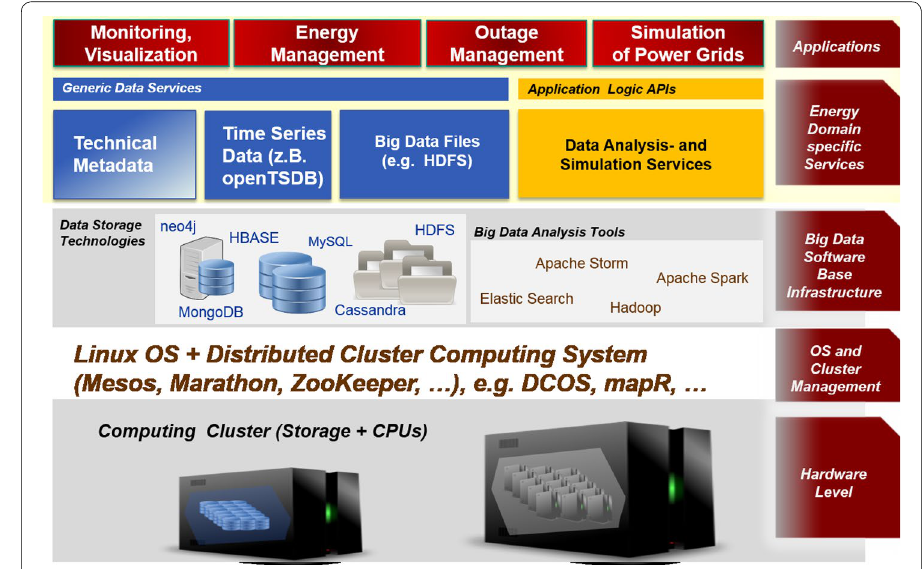
Fig. 1 Big Data energy forecasting